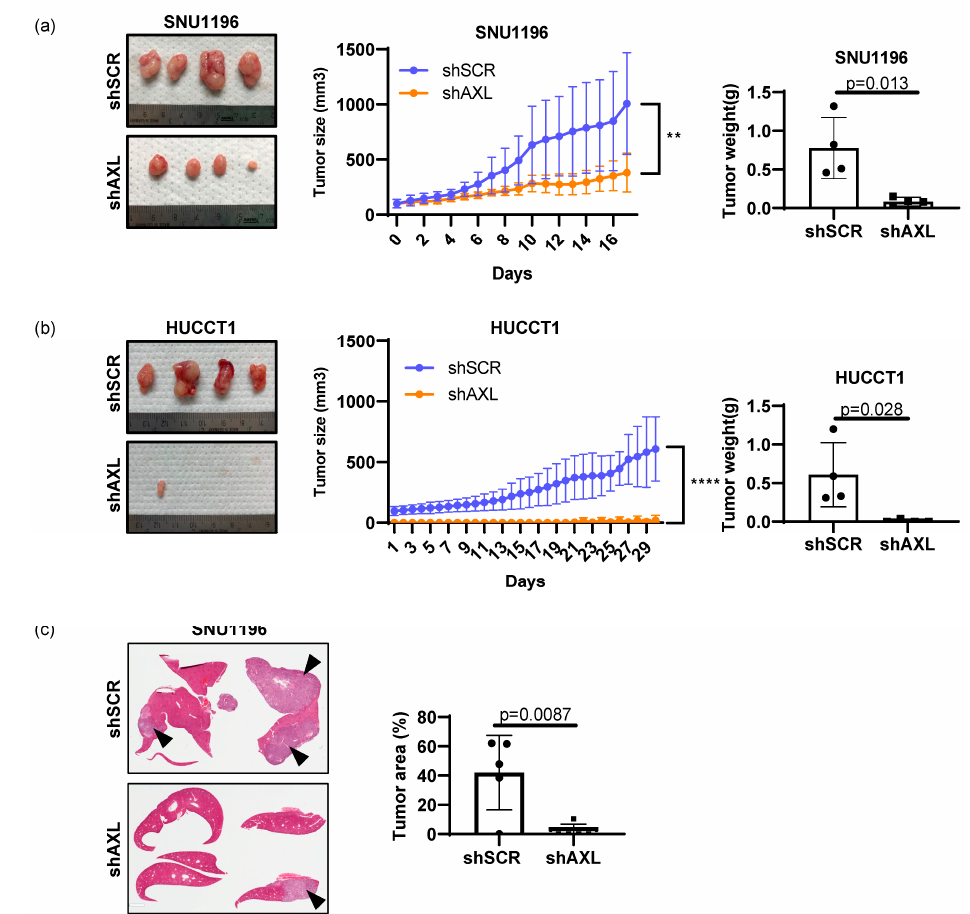
Figure 4. Regulation of tumor cell growth by AXL in vivo. The role of AXL in primary tumor growth was examined by subcutaneously growing ( a ) SNU1196 or ( b ) HUCCT1 in athymic nude mice. AXL knockdown significantly delayed tumor growth in both cell types (n = 4, two-way ANOVA, ** p < 0.01, **** p < 0.0001 for HUCCT1). Tumor weight measurement confirmed tumor growth delay (n = 4, student’s t -test, p = 0.013 for SNU1196 and p = 0.028 for HUCCT1). ( c ) The orthotopic model of bile duct cancer determined that AXL expression is essential for the intrahepatic growth of SNU1196 cells, since intrahepatic tumor growth was significantly inhibited in the absence of AXL expression (n = 5 for each group of shScrambled and shAXL, student’s t -test p = 0.0087, arrows indicate tumor